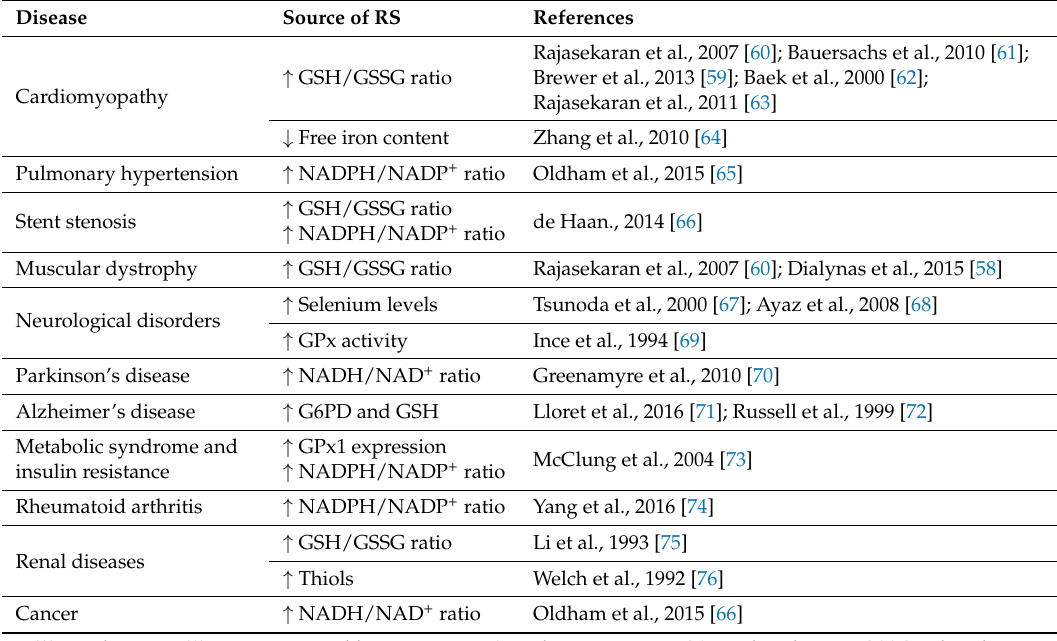
Table 1. Inflammation-associated diseases linked to reductive